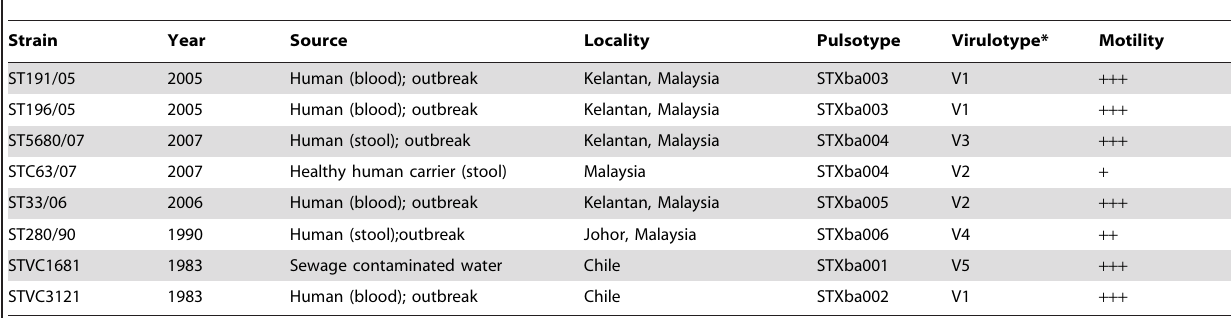
Table 1. Salmonella enterica serovar Typhi strains used in this study.